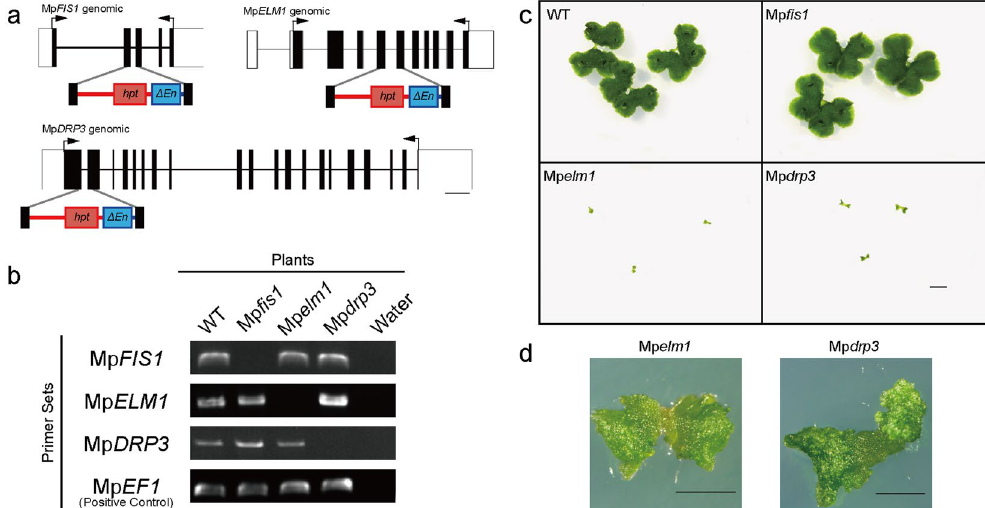
Figure 3. Generation of Mp fis1 , Mp elm1 and Mp drp3 plants by homologous recombination and plant phenotypes of the mutants. ( a ) Schematic representation of the genomic structures of the Mp FIS1 , Mp ELM1 and Mp DRP3 , the disrupting-constructs and their targeting loci. Each primer pair for RT-PCR is indicated by arrows. ( b ) RT-PCR for Mp FIS1 , Mp ELM1 and Mp DRP3 mRNA in wild-type (WT), Mp fis1 , Mp elm1 and Mp drp3 plants. Mp EF1 (Elongation Factor 1 alpha) was used as an internal control. Full-length gel images are presented in Figure S6b. ( c ) Photographs of 2-weeks-old plants of wild-type (WT), Mp fis1 , Mp elm1 and Mp drp3 . All plants shown in this image were grown on a single plate. Bar = 5 mm. ( d ) Magnified images of distorted thalli of Mp elm1 and Mp drp3 by using a stereoscopic microscope. Bars = 1